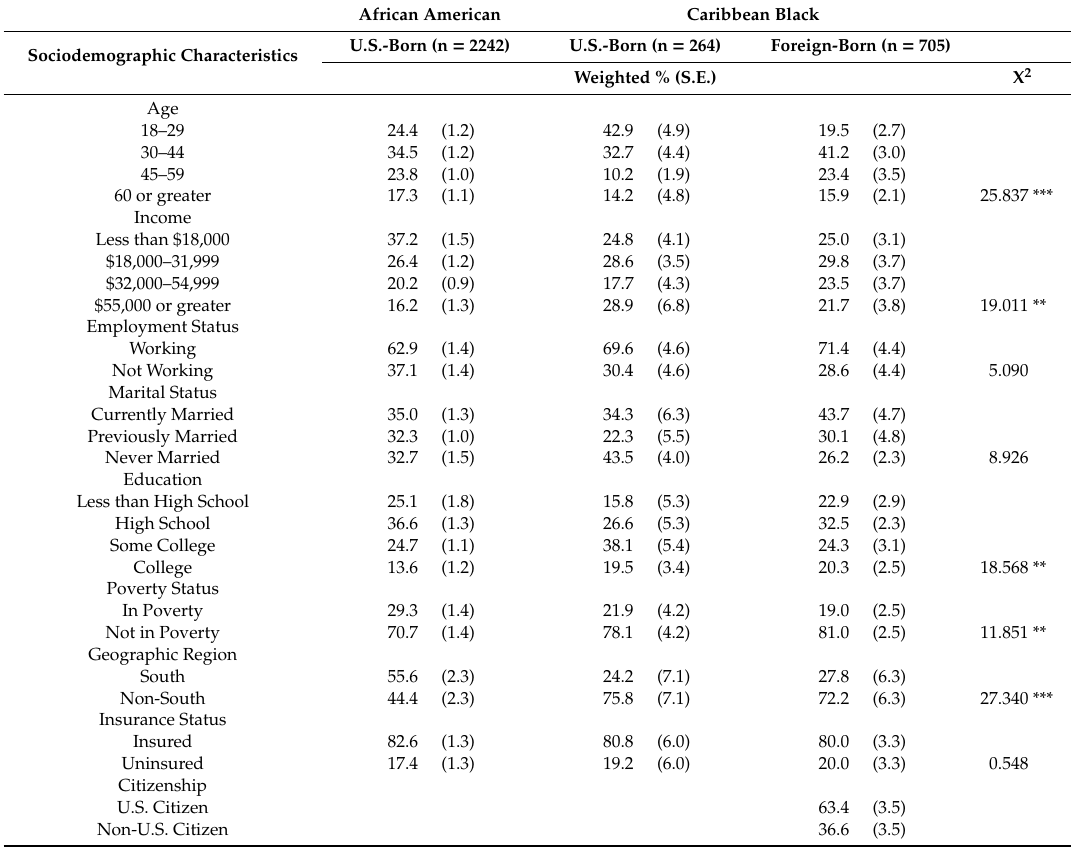
Table 2. Sociodemographic Characteristics of Black Women in the National Survey of American Life, 2001–2003. African American Caribbean Black Sociodemographic